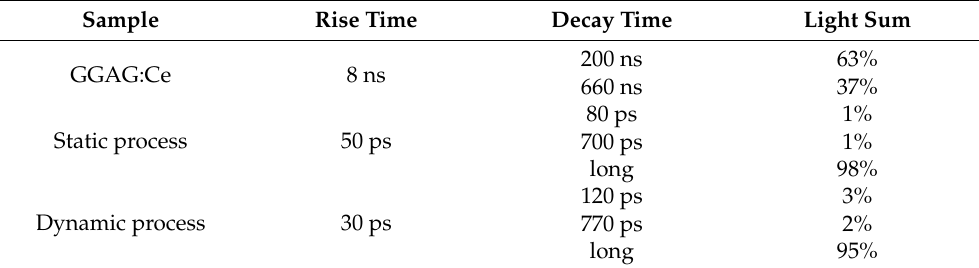
Table 1. Summary of fit rise times and decay times of pure GGAG:Ce measured in the long time window and CsPbBr 3 films on GGAG:Ce prepared by both static and dynamic processes in the short time window. Long components of GGAG:Ce could not be resolved in the short time window.